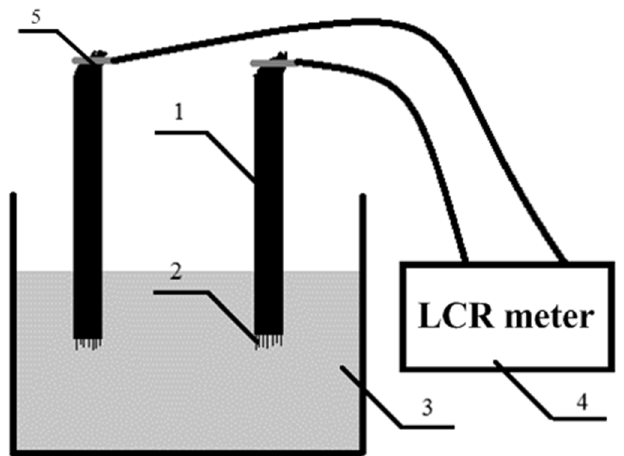
Figure 3. Scheme for measuring the critical length of carbon fibers: 1 is the plastic specimen after tensile test, 2 is the fracture surface of plastic, 3 is the electrolyte solution, 4 is the LCR meter, and 5 is the end of plastic cleaned from the epoxy binder by burning.